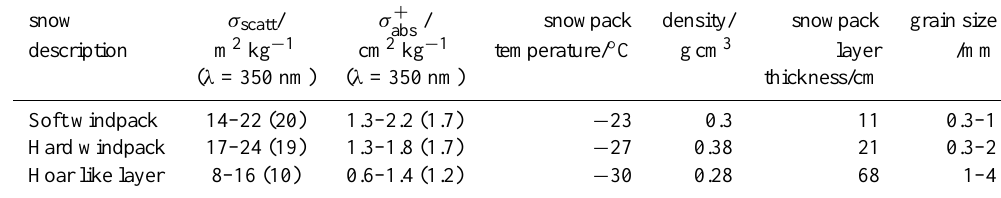
Table 1. Snowpack properties for each snowpack layer at Dome C.